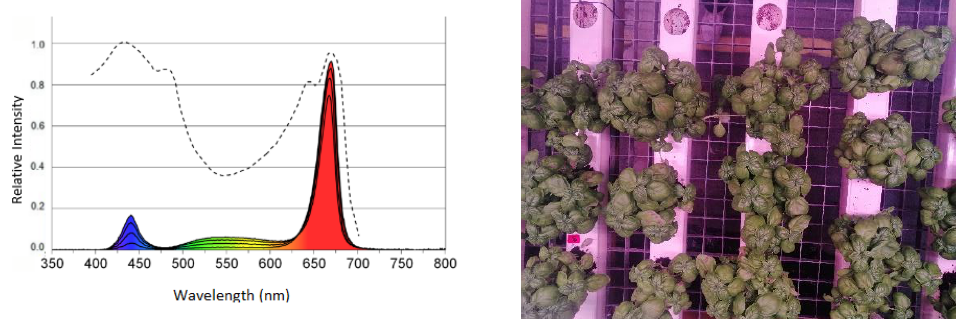
Figure 2. Spectral distribution of the FL100 LED lamp. The dotted line represents the spectral distribution of solar radiation in the relevant wavelengths [22] ( left ); Experimental setup seen from above ( right ).